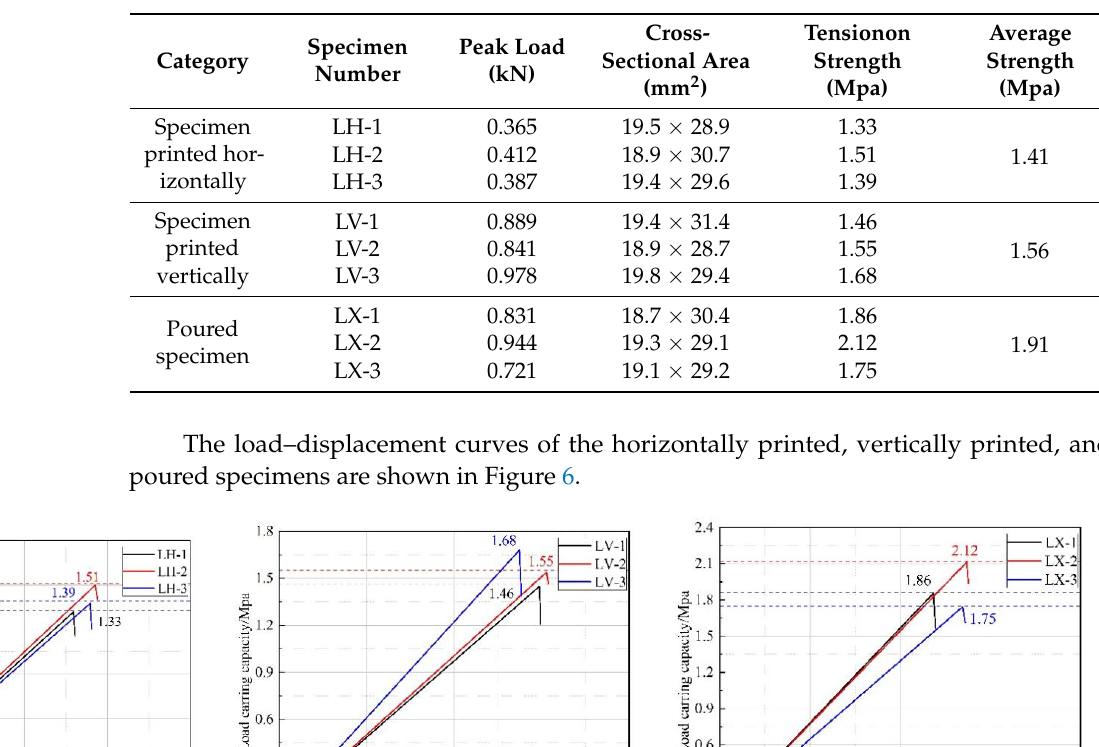
Table 15. Results of the axial tension test.